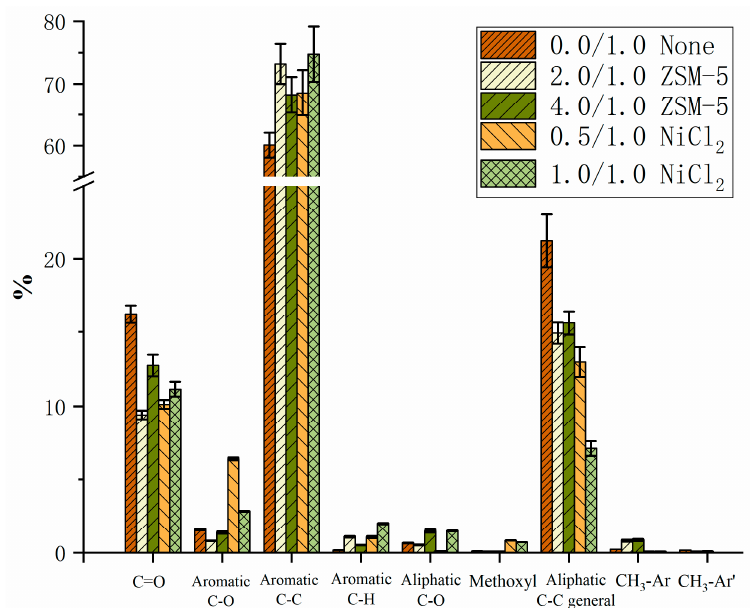
Figure 8. Integration results for the waxy products collected from the pyrolysis of PET powders with 0.0/1.0 (without catalyst), 2.0/1.0 (W ZSM-5 /W PET ), 4.0/1.0 (W ZSM-5 /W PET ), and 0.5/1.0 (W NiCl 2 /W PET ) of NiCl 2